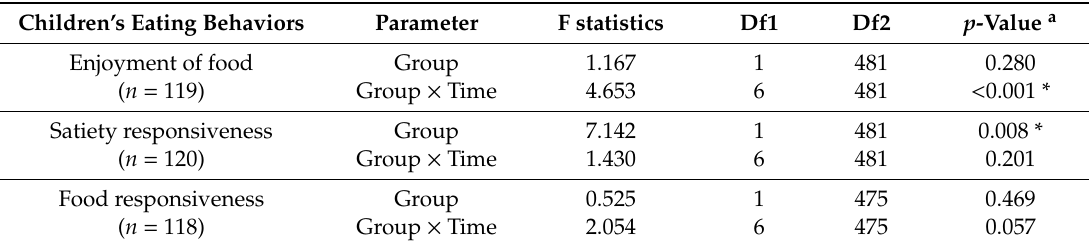
Table 4. E ff ect of REDUCE intervention program on children’s eating behaviors. Children’s Eating